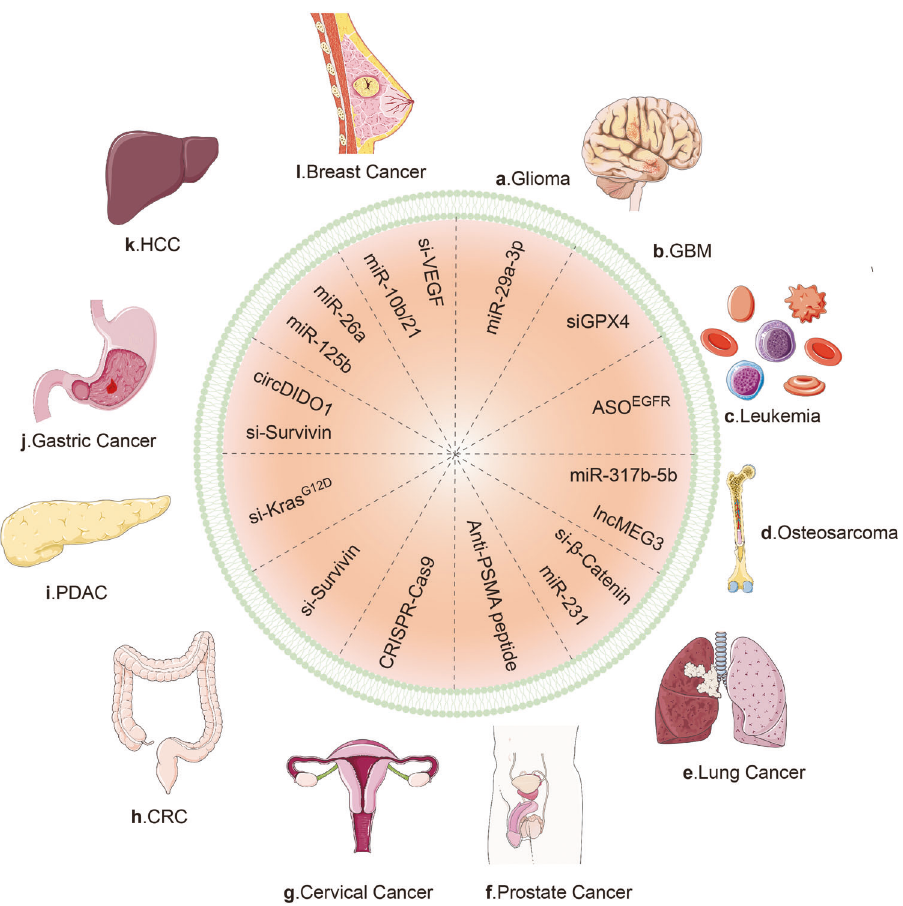
Fig. 4 Genetically engineered exosomes in various cancers. a In glioma, miR-29a-3p-loaded exosomes inhibit tumor migration and vasculogenic mimicry by targeting ROBO1. b In glioblastoma, MNP@BQR@ANG-EXOsiGPX4 platform delivers siGPX4 into tumor cells and subsequently knockdown GPX4, inducing stronger lipid peroxidation and ferroptosis. c In leukemia, ASO EGFR ef fi ciently target EGFR on the cancer cells. d In osteosarcoma, the internalization of miR317b-5b resulted in changes of tumor progression. And cRGD-Exo-MEG3 achieved stronger anti-OS effects than lncMEG3 alone. e In lung cancer, miRNA-231-Exo strongly inhibited cancer proliferation and migration by interrupting the PTEN/PI3K/AKT signaling pathway. Meanwhile, si- β -Catenin led to loss of β -catenin expression and decreased proliferation. f In prostate cancer, anti-PSMA peptide bind to PSMA receptor on the PC cells, triggering receptor-mediated endocytosis and thereafter intracellular drug release. g In cervical cancer, the exosome-based CRISPR-Cas9 delivery exhibited signi fi cant cancer suppression. h In colorectal cancer, si-Survivin knocked down the Survivin gene in tumor cells in vivo. i In PDAC, si-Kras G12D suppressed cancer in multiple mouse models of pancreatic cancer and signi fi cantly increased overall survival. j In gastric cancer, CircDIDO1 regulated the level of the signal transducer inhibitor SOSC2 through sponging miR-1307-3p, therefore inhibiting GC progression. k In hepatocellular carcinoma, miR-26a decreased cell migration and proliferation. l In breast cancer, si-VEGF loaded into exosomes exhibited more signi fi cant antitumor effects than si-VEGF alone. PC prostate cancer. CRC colorectal cancer. PDAC pancreatic ductal adenocarcinoma. PSMA prostate-speci fi c membrane antigen. GPX4 glutathione peroxidase 4. ASO antisense oligo nucleotide. exoASO-STAT6 ASO targeting STAT6. EGFR epidermal growth factor receptor. cRGD-Exo-MEG3 c(RGDyK)-modi fi ed and MEG3-loaded exosomes. LncRNA MEG3 long non-coding RNA maternally expressed gene